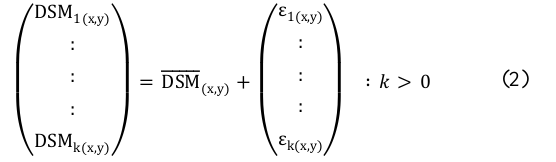
histograms discrepancy(m); Pleiades vs. CP